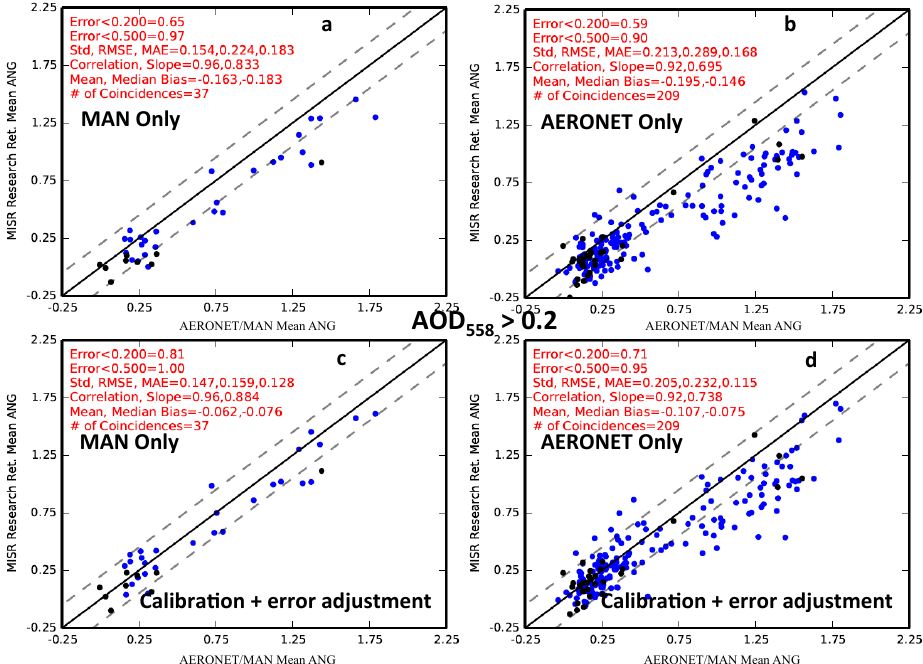
Figure 9. Scatter-plots showing MISR vs. AERONET/MAN ANG data for AOD>0.20, with all modifications (c, d) , and with all modifica- tions except the calibration corrections and the error adjustment (a, b) . The MISR-MAN coincidences are given in panels (a) and (c) , and the MISR-AERONET coincidences correspond to panels (b) and (d) . Blue dots represent coincidences with a MAN/AERONET 558nm AOD of between 0.2 and 0.5. Black dots represent coincidences with AERONET/MAN AOD values>0.5. Statistics for the ANG plots are presented in Table